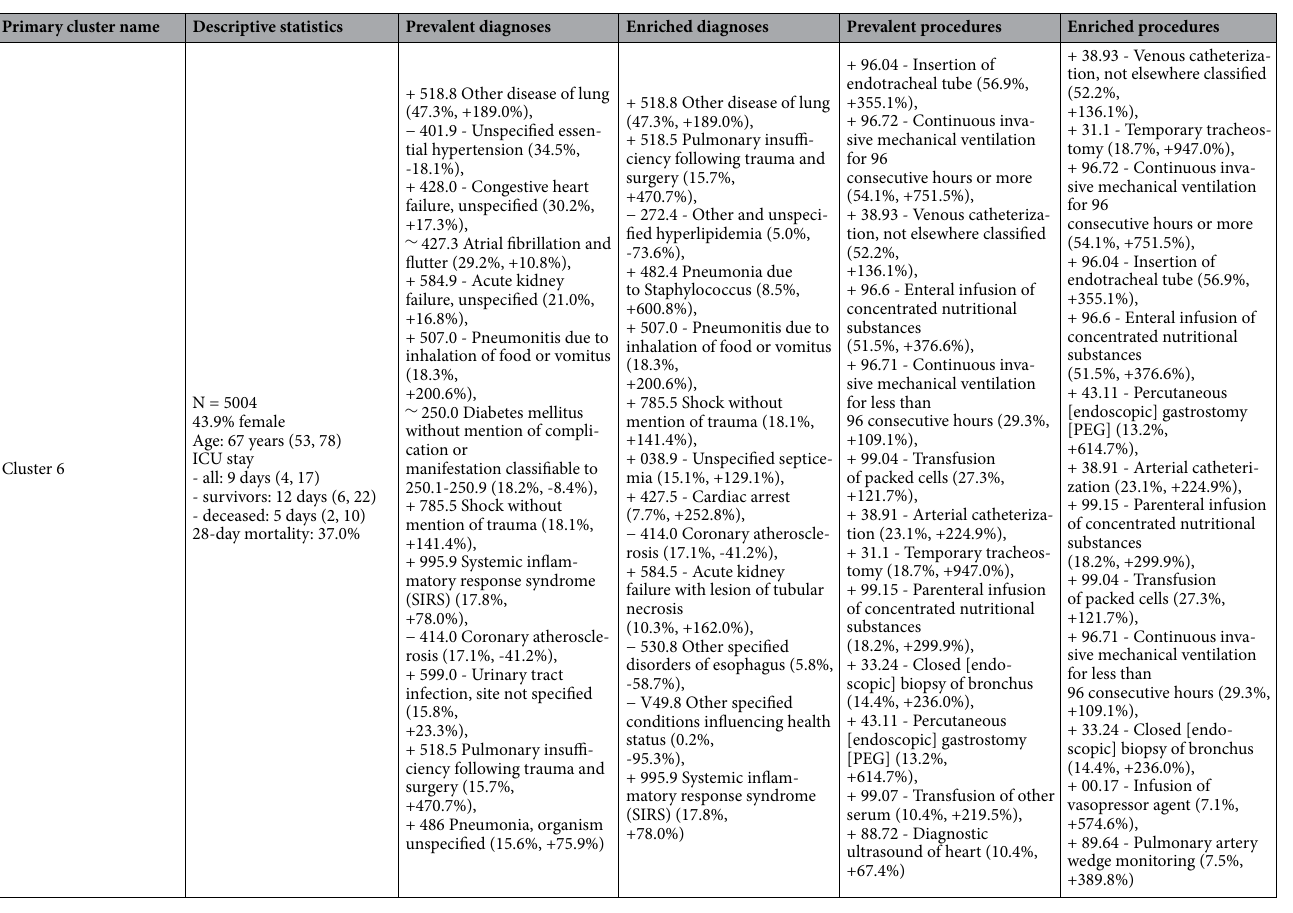
Table 2. Primary clustering results. Large differences between the clusters in terms of age distribution, length of ICU stay, and mortality can be observed. Distributions of ICD-9 diagnoses vary strongly between clusters. (For information about the population, please refer to Table